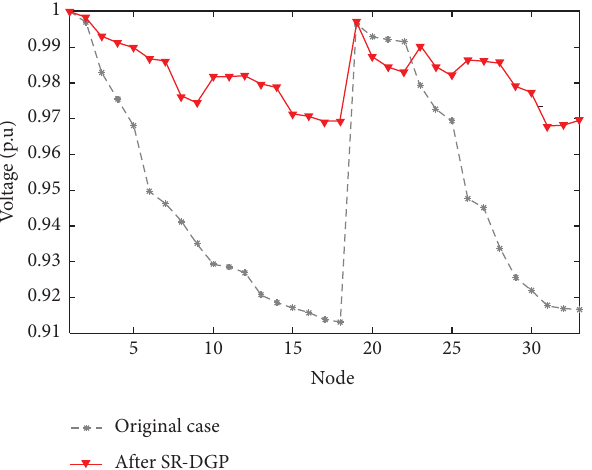
Figure 3: Voltage profles before and after SR-DGP for 33-node system.